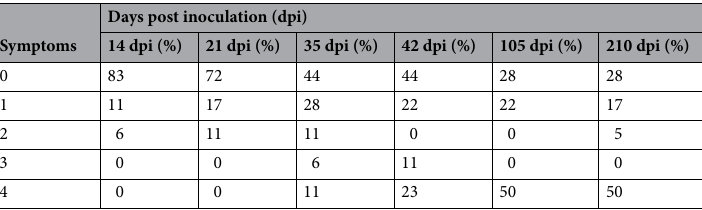
Table 1. Symptoms’ progression in selected timepoints. Symptoms were evaluated weekly for 210 days post- inoculation (dpi) and registered according to a five-level scale based on percentage of brown/wilted